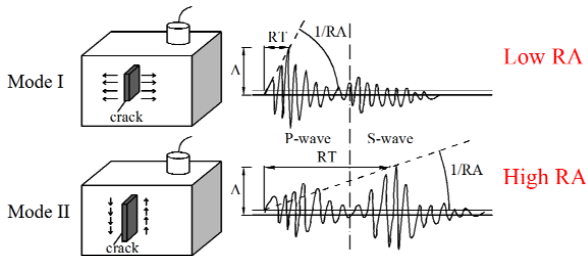
Figure 1. Typical waveforms for tensile and shear events. A is the amplitude and RT is the rise time (time between the onset and the point of maximum amplitude) of the waveforms. Reproduced with permission from [7], Elsevier, 2016.